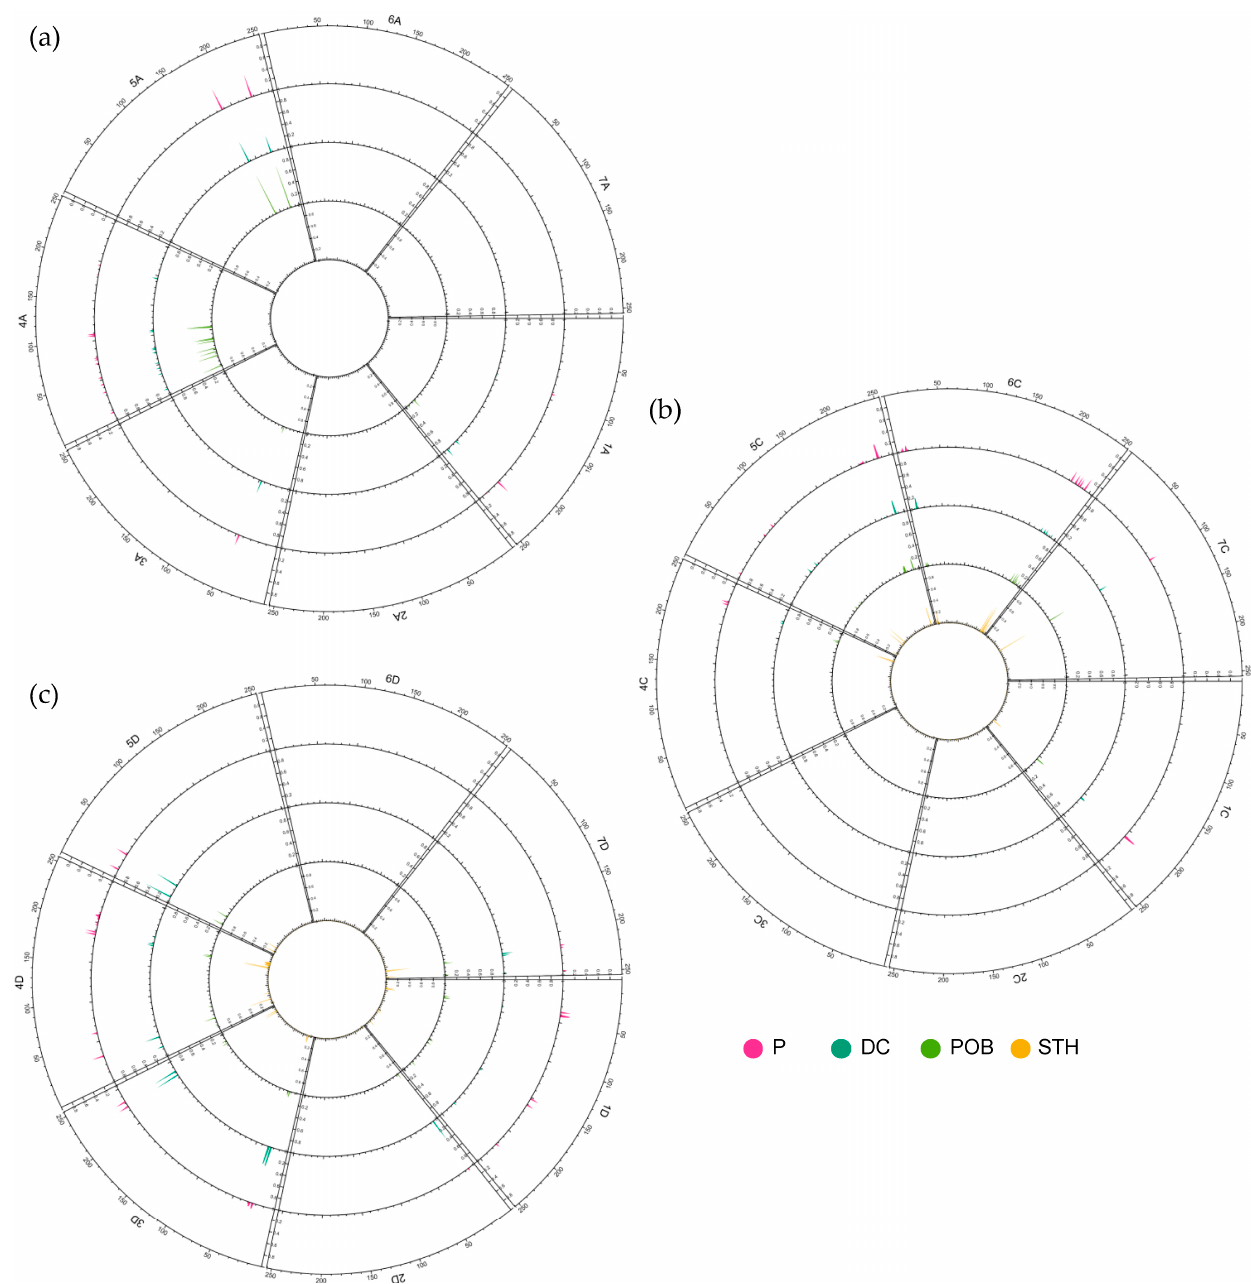
Figure 8. Loci containing alleles unique to Swan mut present in Polish A. sativa cultivars and breed- ing materials; ( a ) A sub-genome; ( b ) C sub-genome; and ( c ) D sub-genome. DC—materials from Ltd.; and STH—materials from Strzelce Plant Breeding DANKO Plant Breeding Ltd.; P—Polish modern cultivars; POB—materials from Ma ł opolska Plant Breeding Ltd.; and STH—materials from Strzelce Plant Breeding Ltd.